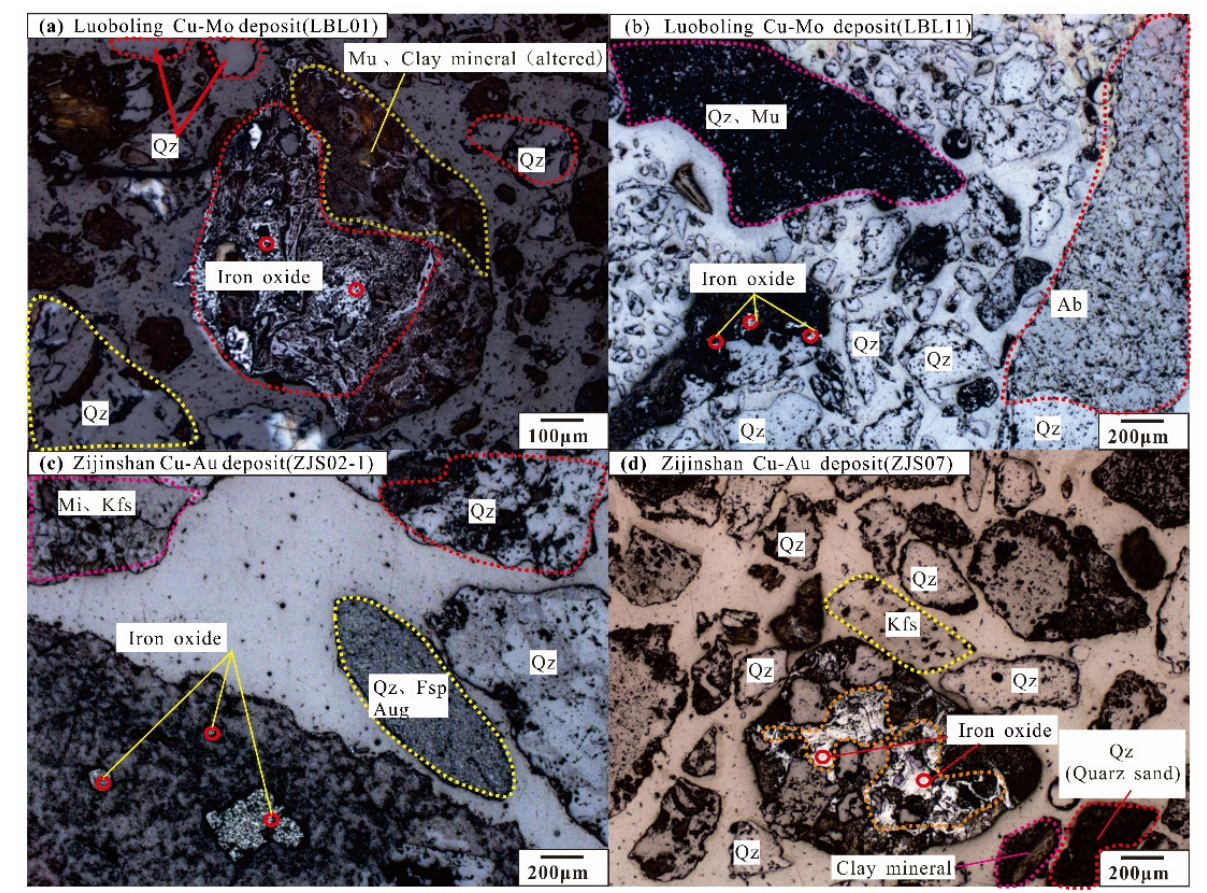
Figure 4. Microscopic photographs of stream sediments in the Zijinshan Orefield. (Ab, albite; Qz, quartz; Mu, muscovite; Fsp, feldspar; Mi, mica; Kfs, potash feldspar; Aug, augite). ( a ) Stream sediment numbered LBL01 around Luoboling Cu-Mo deposit; ( b ) Stream sediment numbered LBL11 around Luoboling Cu-Mo deposit; ( c ) Stream sediment numbered ZJS02-1 around Zijinshan Cu-Au